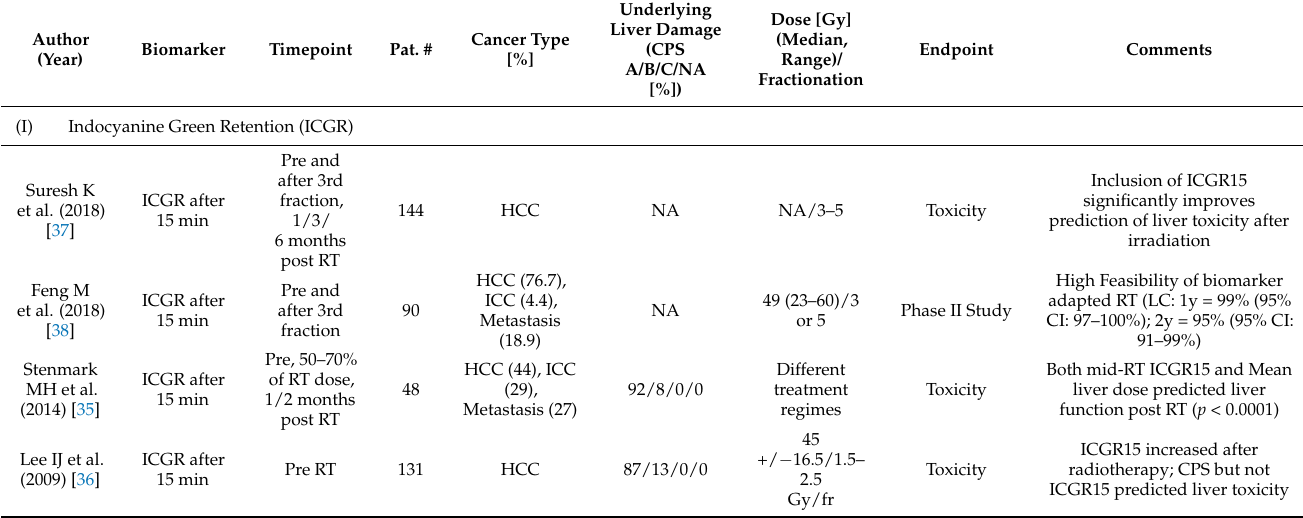
Table 2. Candidate biomarkers of radiotherapy outcomes in liver cancer